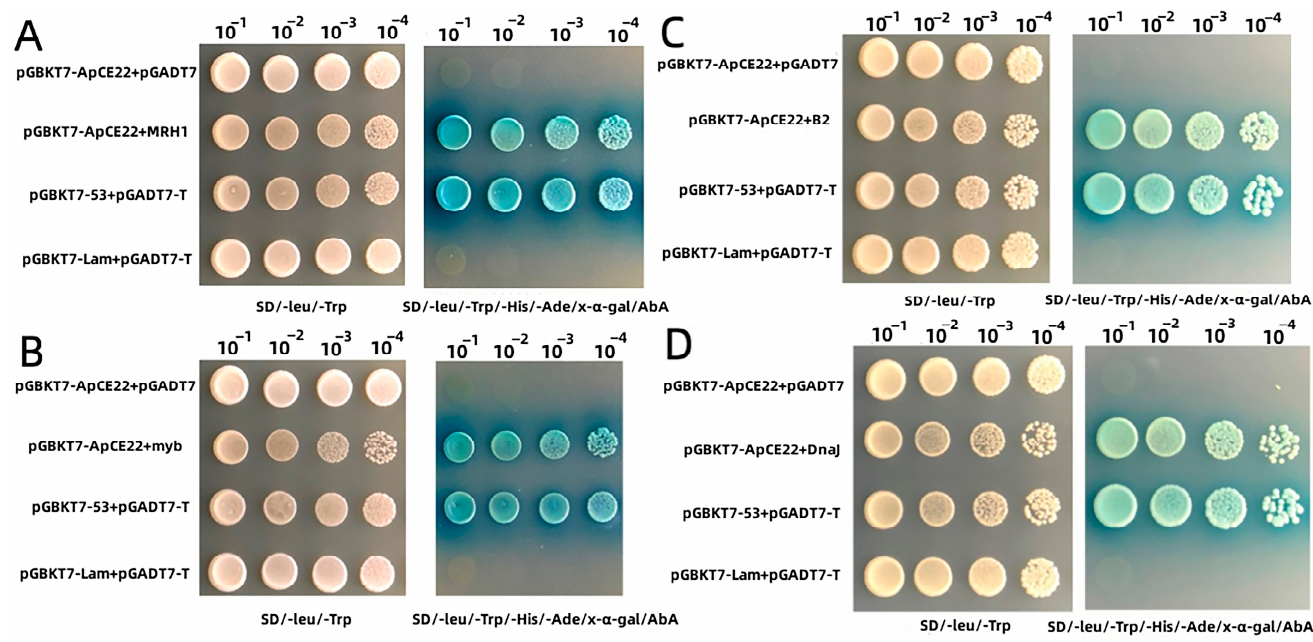
Figure 2. One-to-one yeast two-hybrid results of the interacting proteins and ApCE22 . Note: In- teraction proteins were as a prey protein, and ApCE22 protein was as a bait protein. ( A ): One-to-one yeast two-hybrid results of MRH1 proteins and ApCE22. ( B ): One-to-one yeast two-hybrid results of B2 proteins and ApCE22 . ( C ): One-to-one yeast two-hybrid results of myb proteins and ApCE22. ( D ): One-to-one yeast two-hybrid results of DnaJ proteins and ApCE22.